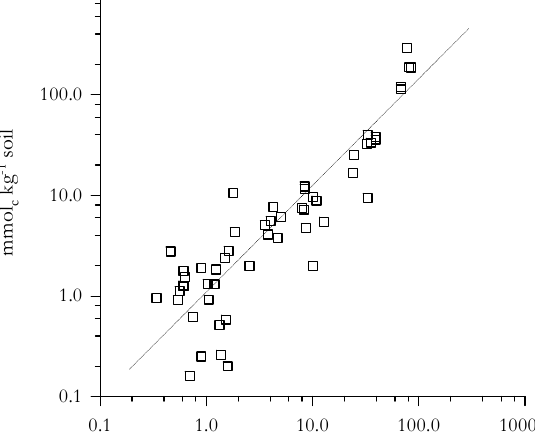
Fig. 3. Cation extraction methods compared. (a) Cation exchange capacity (CEC) as determined by NH 4 Ac (pH 7) and effective CEC (ECEC) as estimated by summing extractable bases (NH 4 Ac) and extractable aluminium (KCl) together, both plotted as a function AgTU extracted ECEC (sum of bases plus aluminium) (b) Base saturation calculated using NH 4 Ac (pH 7) as a function of base sat- uration estimated with